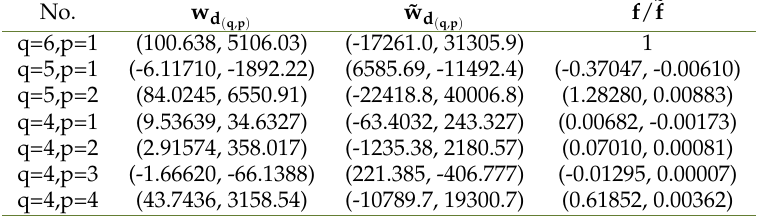
Table 2. TIFV using Coiflet 1.